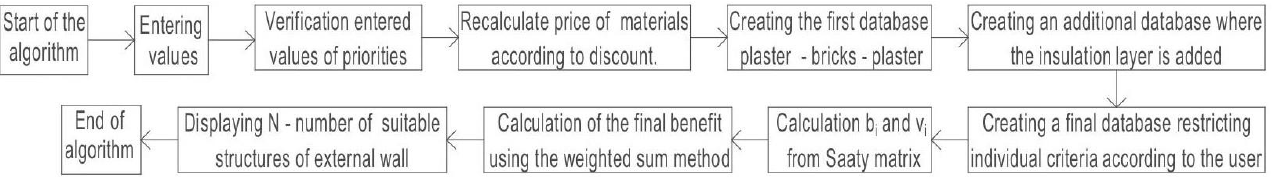
Figure 4. Simplified summary procedure of the algorithm for the second possibility to search for the structures of external walls.